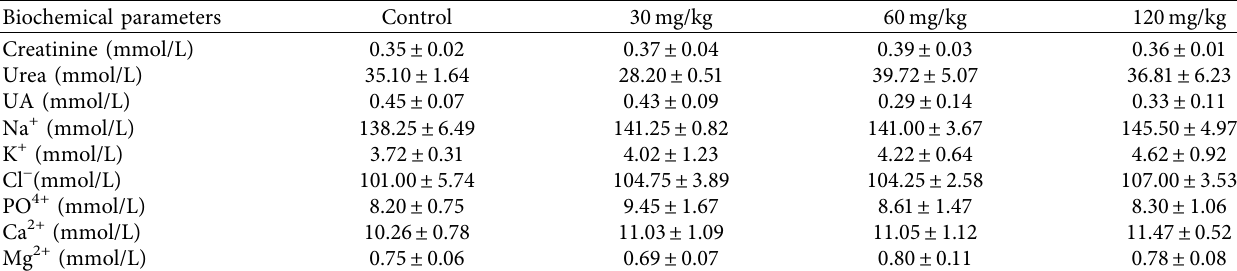
Table 5: The effects of goose bone on serum renal markers.